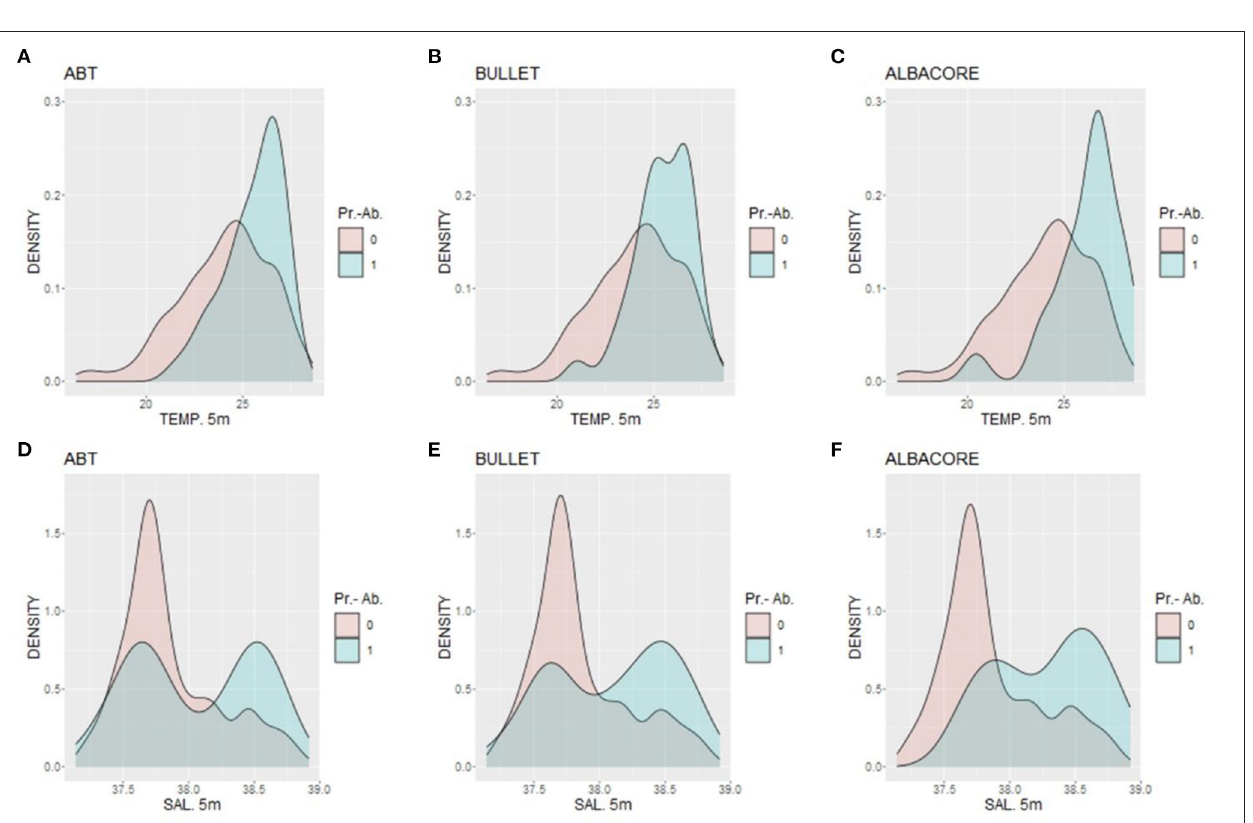
FIGURE 4 | Density of presence-absence data for the three species related to (A–C) temperature and (D–F) salinity, where 0 is absence and 1 is